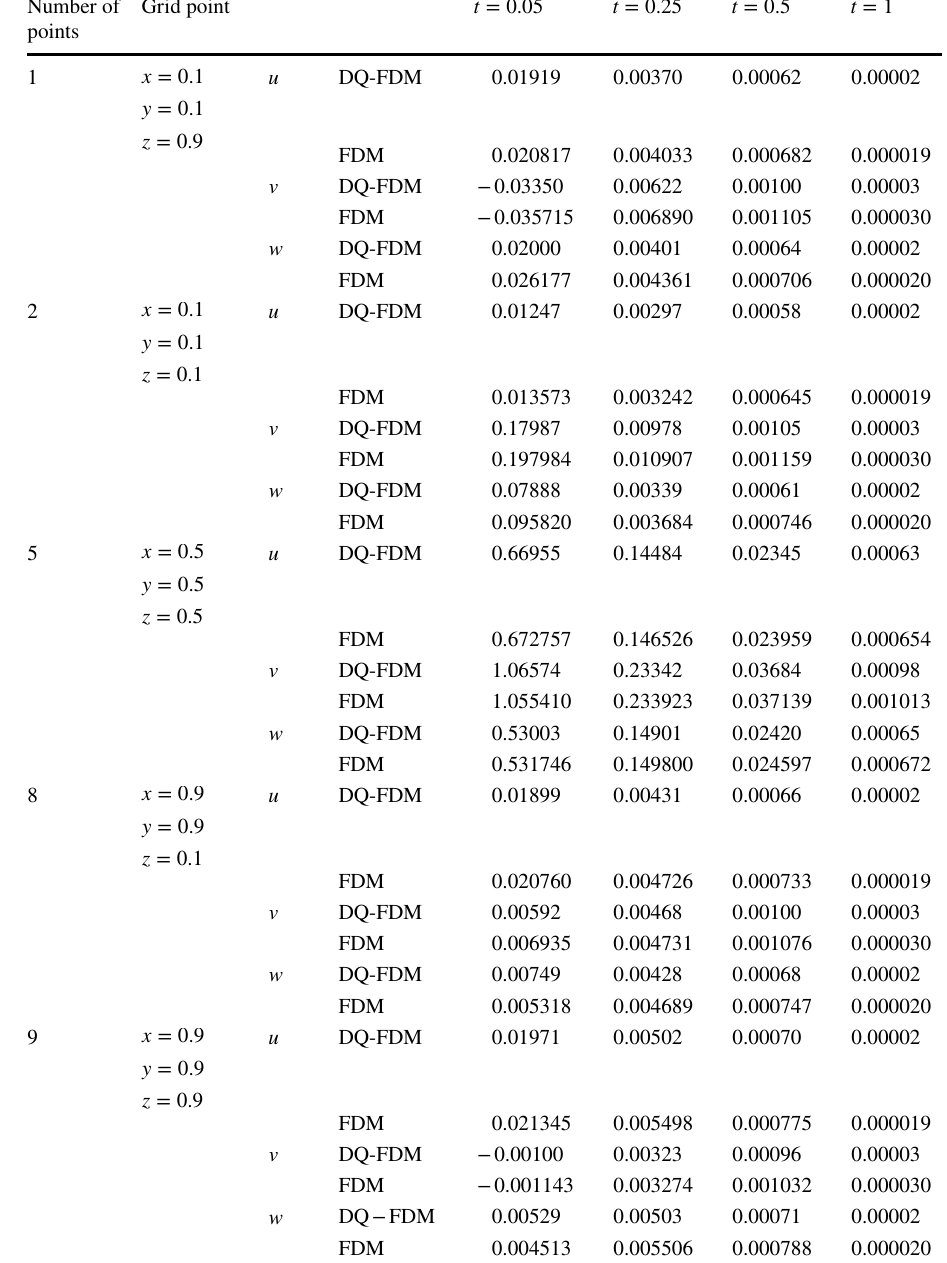
Number of Grid points 𝜐 = 0.25 and